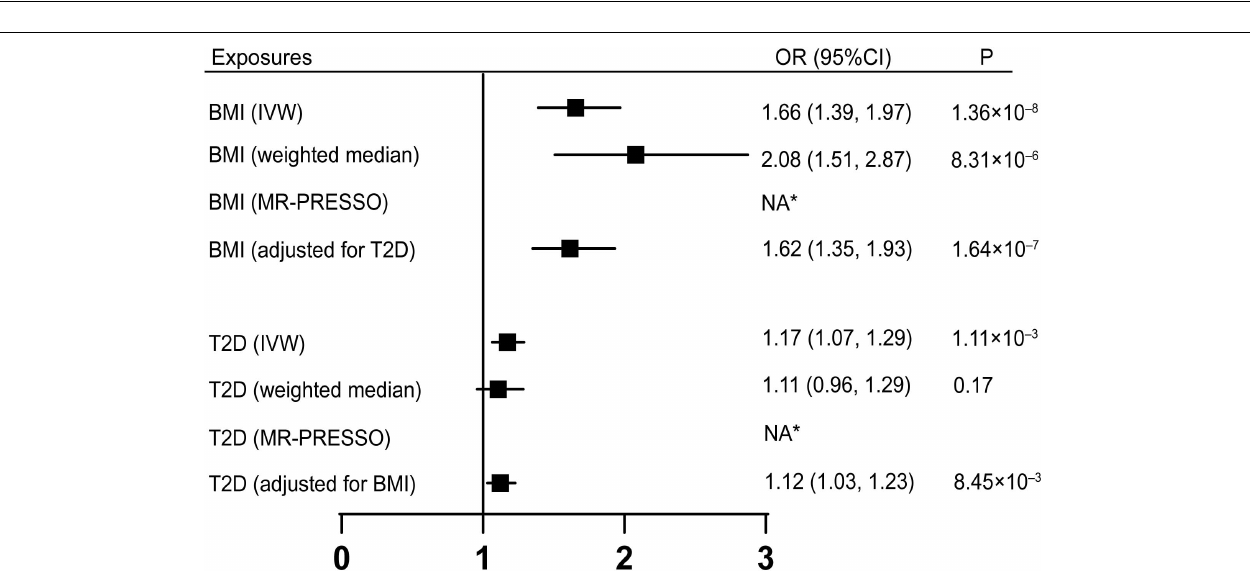
FIGURE 2 | Univariable MR and multivariable MR analyses showed genetically proxied BMI and T2D were independent risk factors of carpal tunnel syndrome. Univariable MR was performed with IVW, weighted median, and MR-PRESSO methods. Multivariable MR was performed to assess the effect of T2D on CTS adjusted for BMI and the effect of BMI adjusted for T2D. *No outlier detected. IVW, inverse-variance-weighted; BMI, body mass index; T2D, type 2 diabetes; OR, odds ratio; CI, confidence interval; MR, Mendelian randomization.